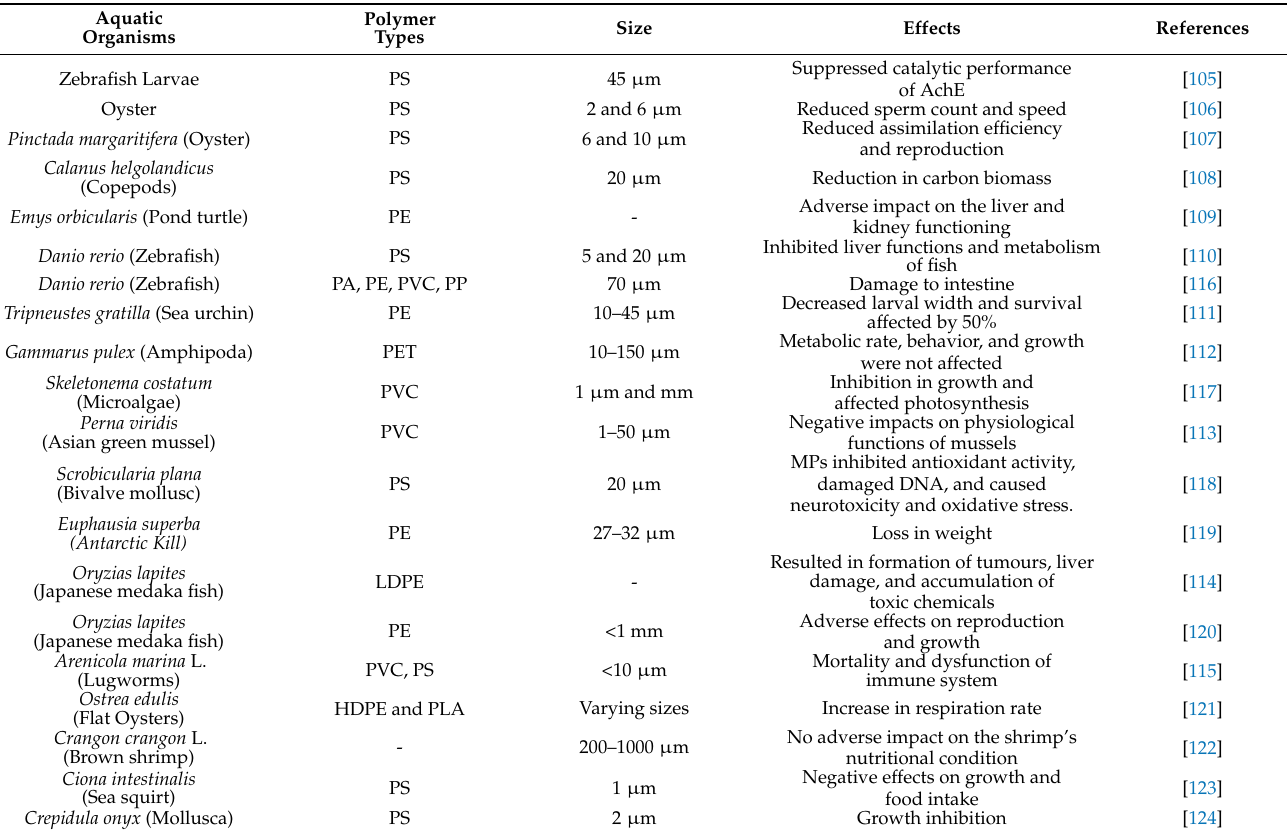
Table 4. Effects of MPs on aquatic